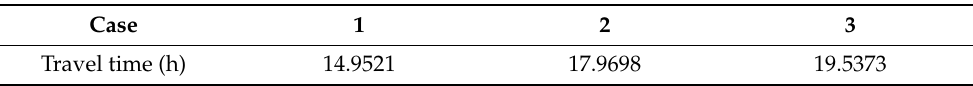
Table 8. The coordinates and depths of starting point and target point in the 3D-MDP algorithm simulation.